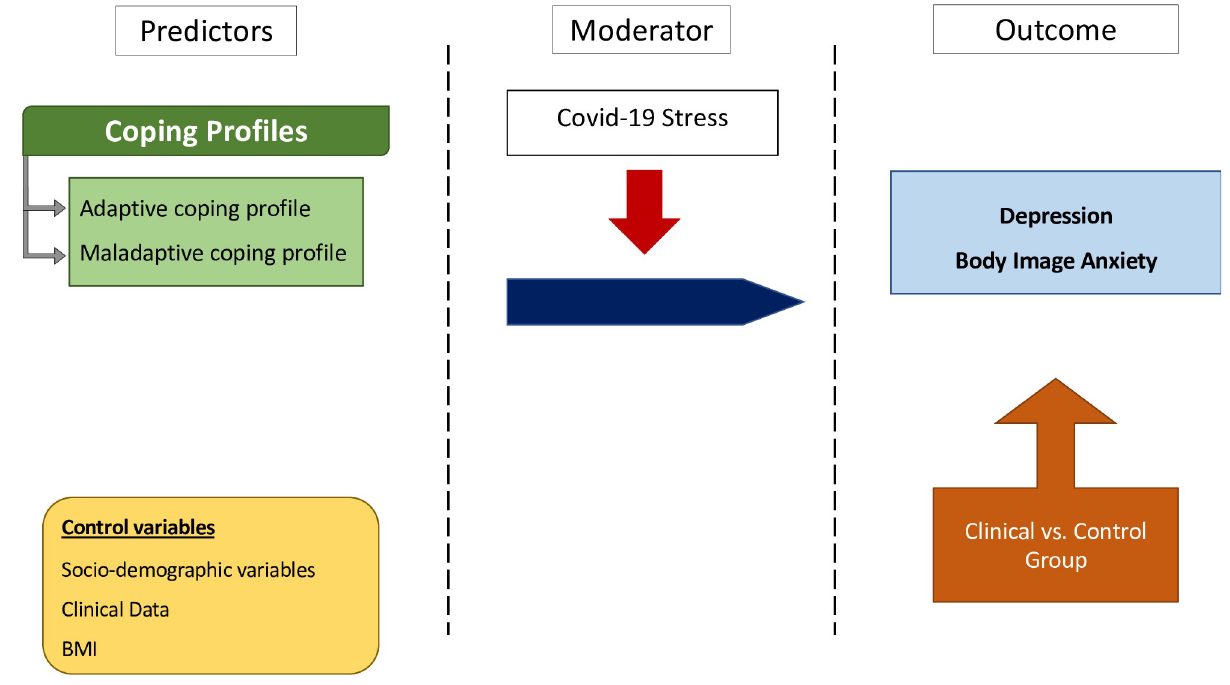
Fig 1. Data analysis